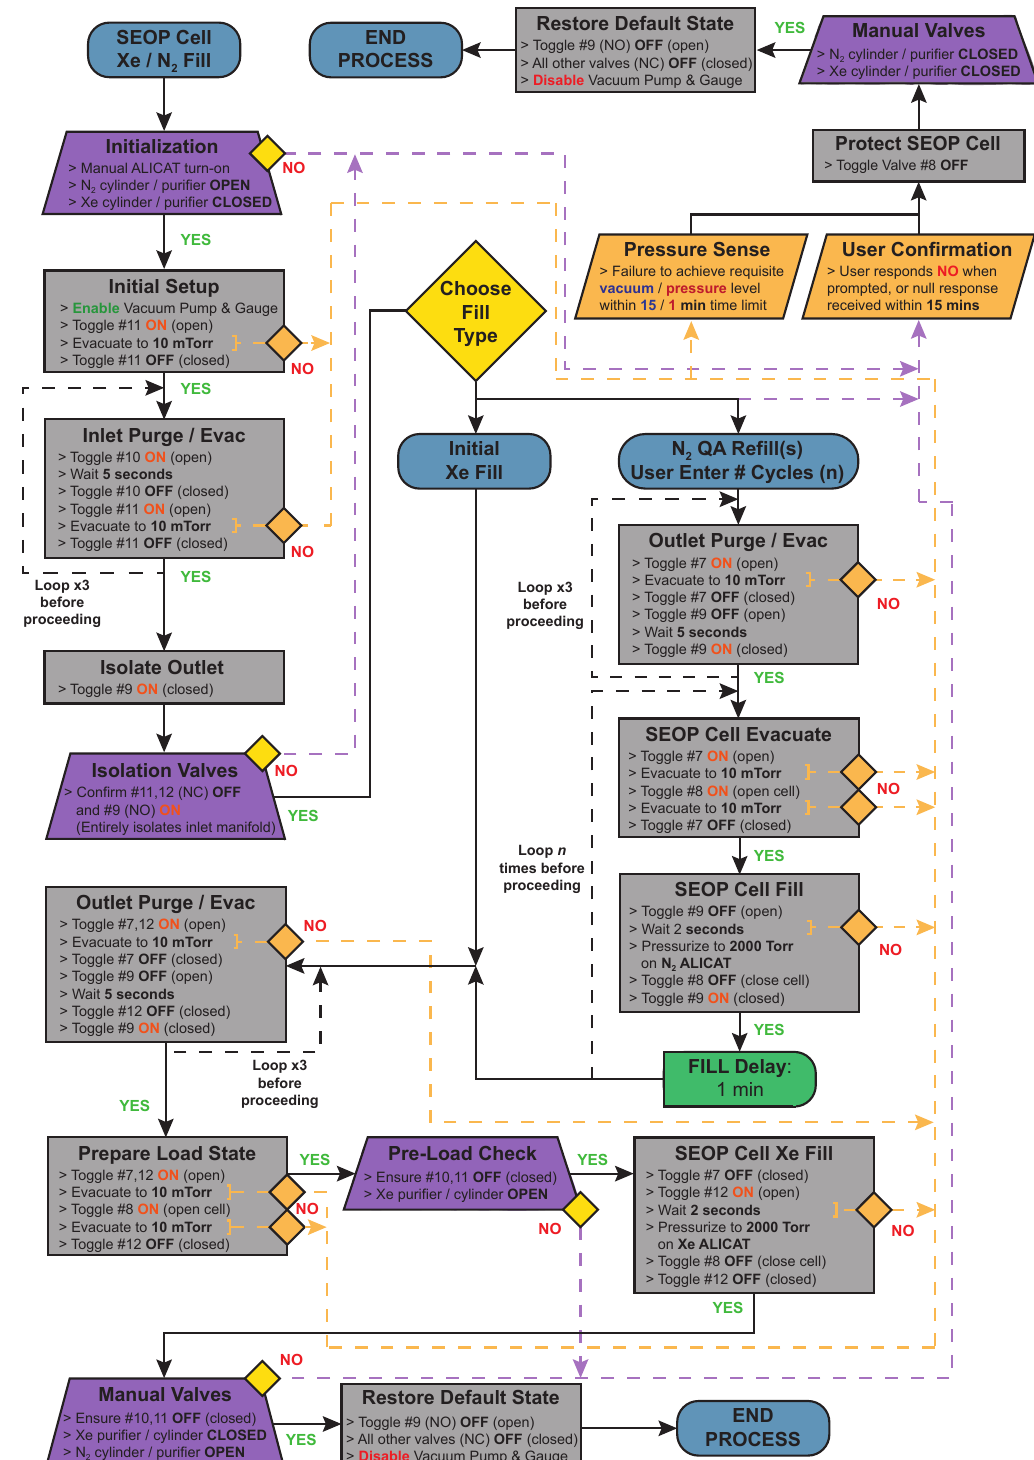
Figure 5. Process flowchart depicting the automated SEOP cell reloading quality assurance (QA) refill sequence coded into the GEN-3 129 Xe hyperpolarizer driver module for the purpose of evacuating and refilling SEOP cells. Note, the yellow diamonds indicate condition states. For example, when the user does not provide input within 15 min, the sequence follows the “NO” path. Another example is vacuum level reaching 10 mTorr, which has to be achieved within 15 min, otherwise the sequences defaults to the “NO” path. The timeout duration is 15 min for all yellow diamonds. The valve numbering is provided in Figure